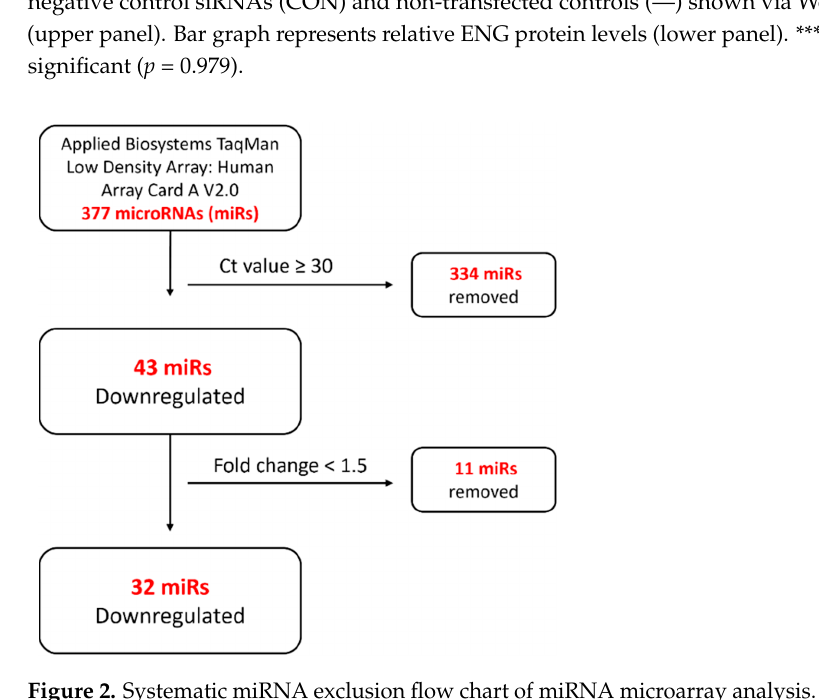
Figure 2. Systematic miRNA exclusion flow chart of miRNA microarray analysis. Ct: cycle threshold. Table 1. Dysregulated miRNAs identified by the microarray analysis after systematic exclusion.